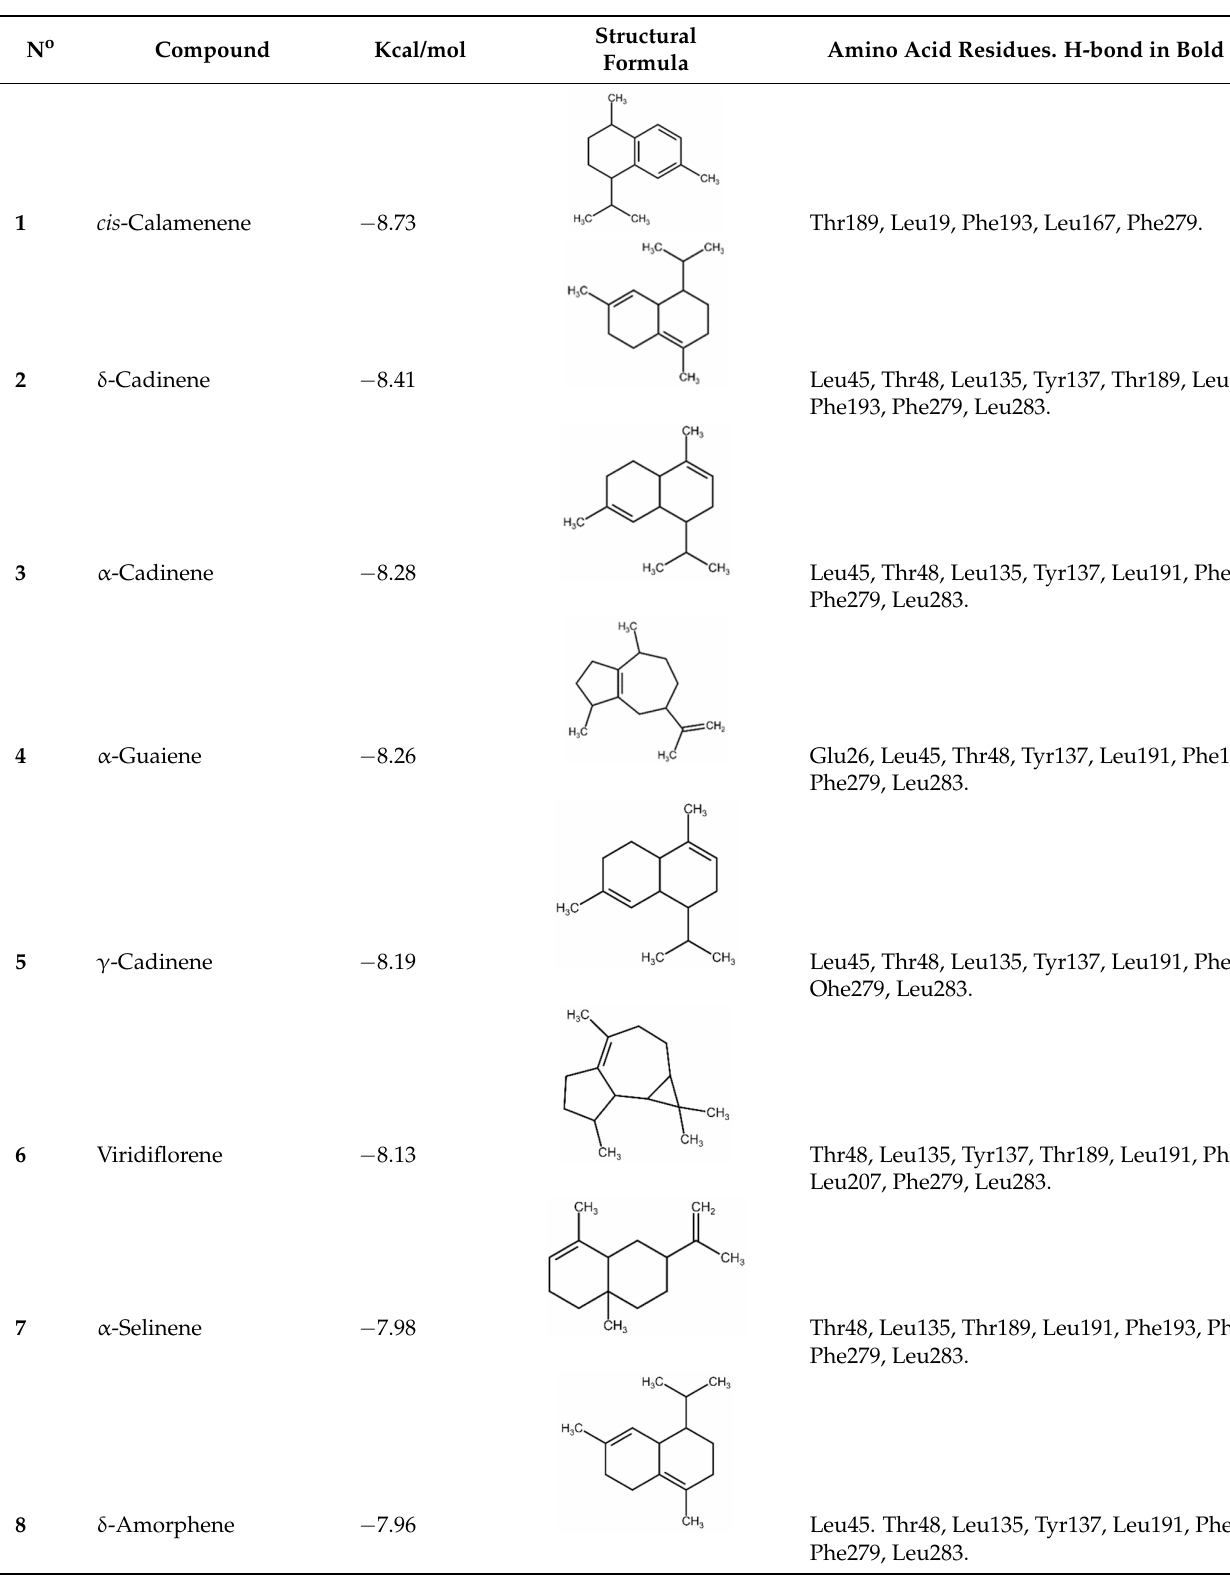
Table 4. Essential oil sesquiterpenes and monoterpenes with the lowest binding free energy for DENV-2 E